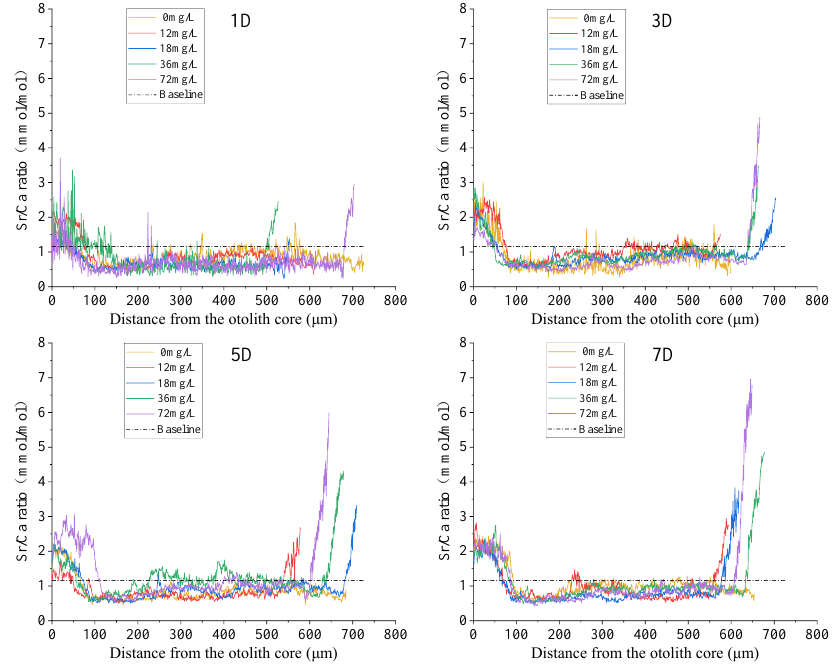
Figure 1. The Sr/Ca ratios in the otoliths of T. obscurus in different concentrations. Figure 1. The Sr / Ca ratios in the otoliths of T. obscurus in different concentrations. The Sr/Ca ratios in the otoliths of T. obscurus were analyzed 25 d after immersion, which verified the persistence of the marking with strontium (Figure 2). The ratios of marked groups were 1.86 ± 0.06 mmol/mol (12 mg/L), 2.39 ± 0.06 mmol/mol (18 mg/L), 3.02 ± 0.08 mmol/mol (36 mg/L), and 3.61 ± 0.34 mmol/mol (72 mg/L), which were 1.6, 2.05, 2.6, and 3.1 times the detection baseline, respectively. The Sr/Ca ratios in the marked groups showed crests with a width of approximately 0.1 mm in the region of 0.5 – 0.7 mm from the core to the edge of otoliths. When the fish were reared again in water without added strontium, the Sr/Ca ratio returned to the previous level. Thus, the success rate of marking by exogenous strontium was 100%.